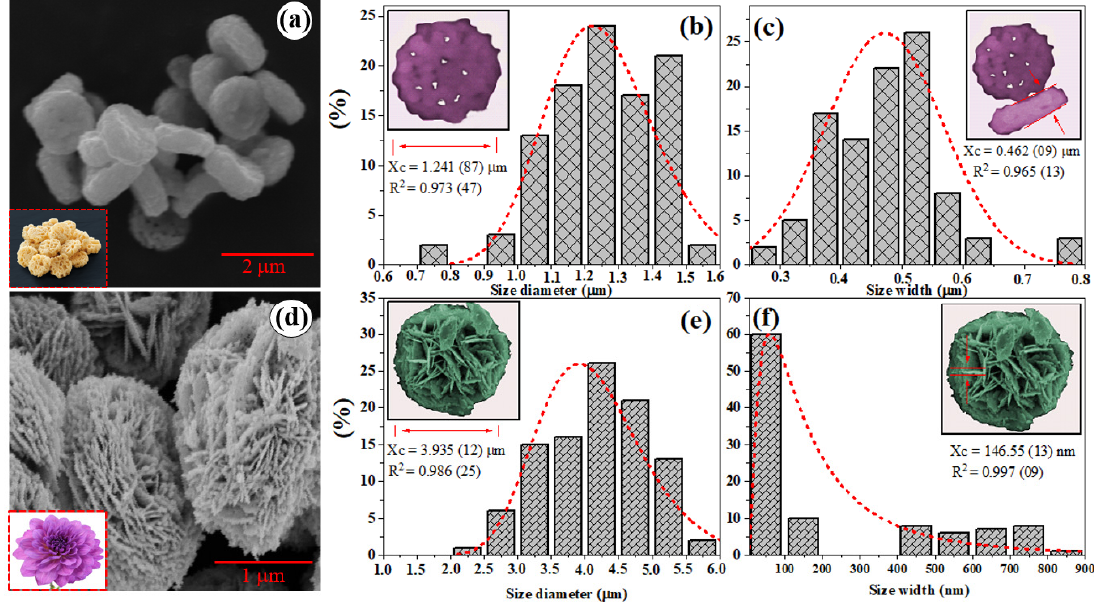
Figure 3. SEM images of ( a ) Bi 2 WO 6 -glyc and ( d ) Bi 2 WO 6 and histograms for size diameter and size width for Bi 2 WO 6 -glyc ( b , c ) and Bi 2 WO 6 ( e , f ).